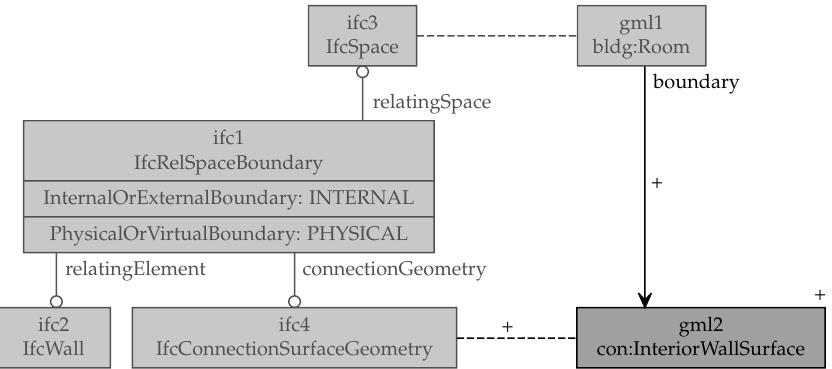
Figure 6. Example of a triple graph rule transforming an interior wall surface from IFC into CityGML. The left-hand-side of the rule (indicated in grey) specifies four IFC nodes, their mutual edges, and a correlated CityGML node; the right-hand-side of the rule (indicated in black with a plus sign) adds a CityGML node and a correlation edge between an existing IFC node and the new CityGML node.